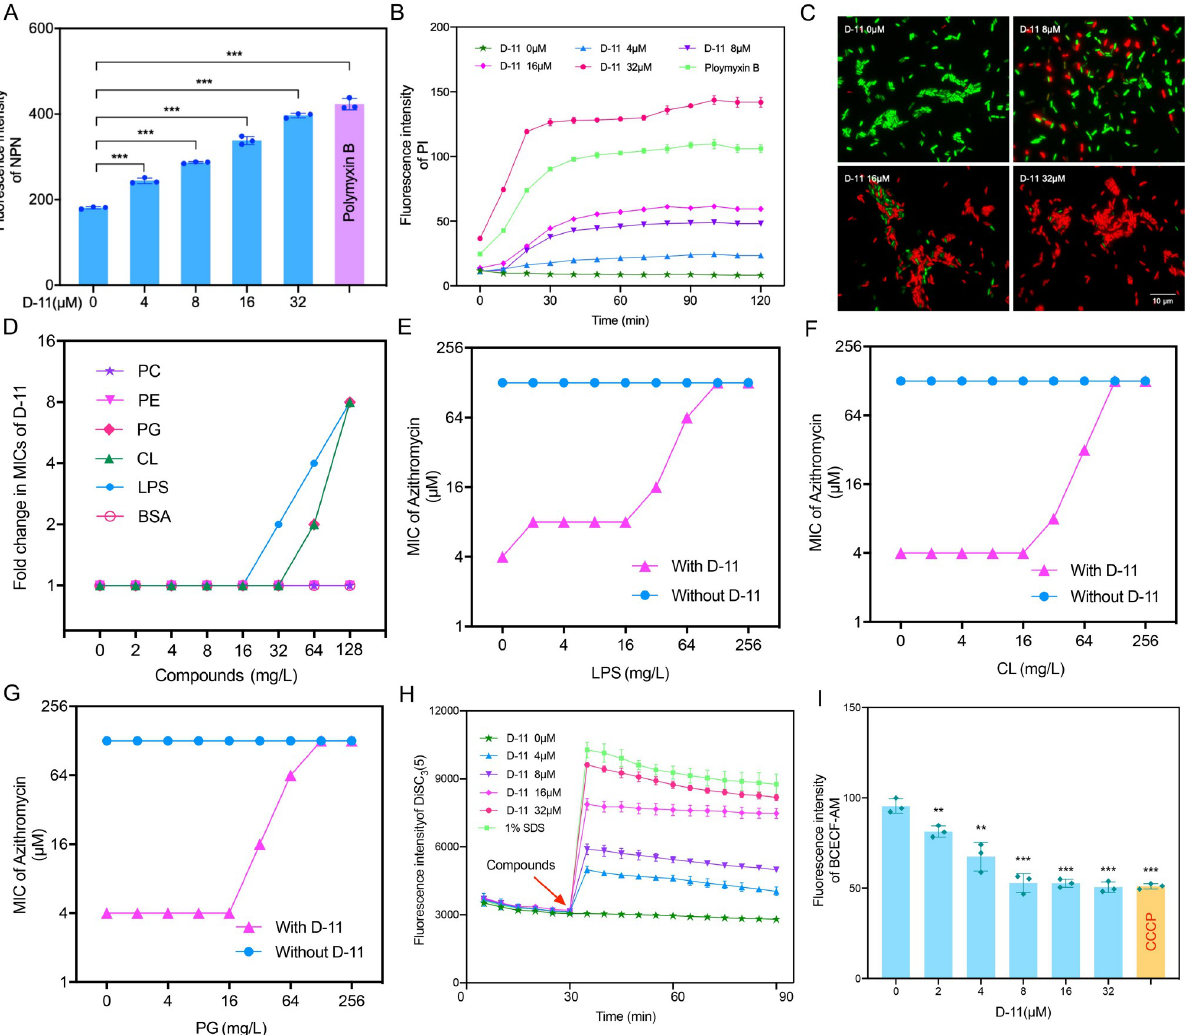
Fig 2. D-11 increases membranes permeability, interacts with LPS and phospholipids and dissipates the membrane potential. ( A ) D-11 dosage- related outer membrane permeability increment. Polymyxin B at 0.5mg/L was used as a positive control. ( B ) D-11 dosage-related inner membrane permeability increment. 0.5 mg/L polymyxin B was used as a positive control. ( C ) SYTO9 and PI live/dead cell staining of PAO1 treated with D-11. P . aeruginosa cells were treated with indicated concentrations of D-11 for 60 min. Cells were washed with PBS buffer and stained with SYTO9 and PI before being inspected with a microscope. ( D ) D-11 activity in the presence of BSA, PC, PE, PG, CL or LPS, the activity for the synergistic relation D- 11/azithromycin in the presence of LPS ( E ), CL ( F ), and PG ( G ). D-11 lost the synergistic effect in the presence of LPS, CL or PG. The MIC of azithromycin was determined by checkerboard microdilution assays in the presence of LPS, CL or PG (0–256 mg/L) with 4 μ M of D-11 or not. ( H ) DiSC3(5) membrane potential measurement for several D-11 dosages. Polymyxin B at 0.5mg/L was used as a positive control. The DiSC3(5) dye was incubated with PAO1 for 30 min followed by self-quenching and stabilization, then indicated concentrations of D-11 and SDS were added. The fluorescence units were monitored for 60 min. ( I ) PMF disruption measurement. CCCP was used as a positive control. All the tests were performed in triplicate and all the data are presented as mean ± SD. �� , P < 0.01; ��� , P < 0.001 by Student’s t-test.